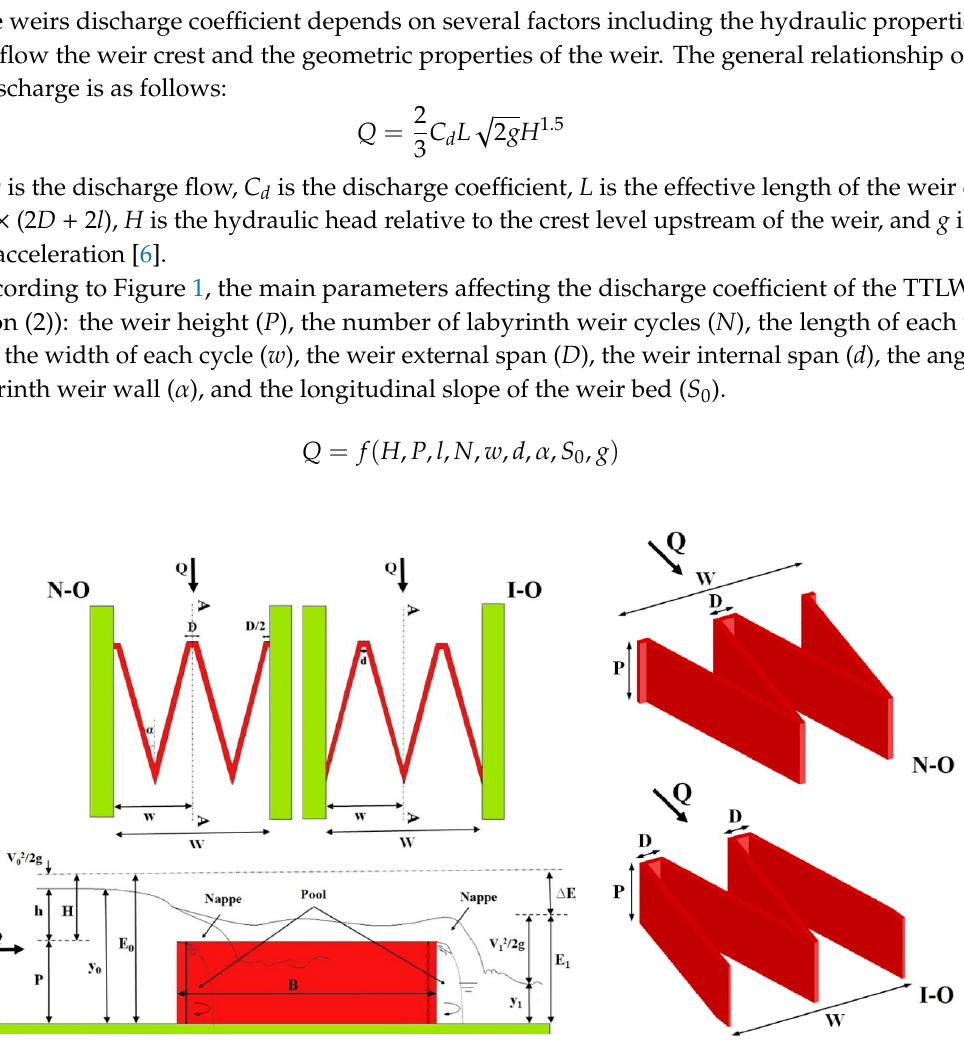
Figure 1. The effective parameters of the trapezoidal–triangular labyrinth weir